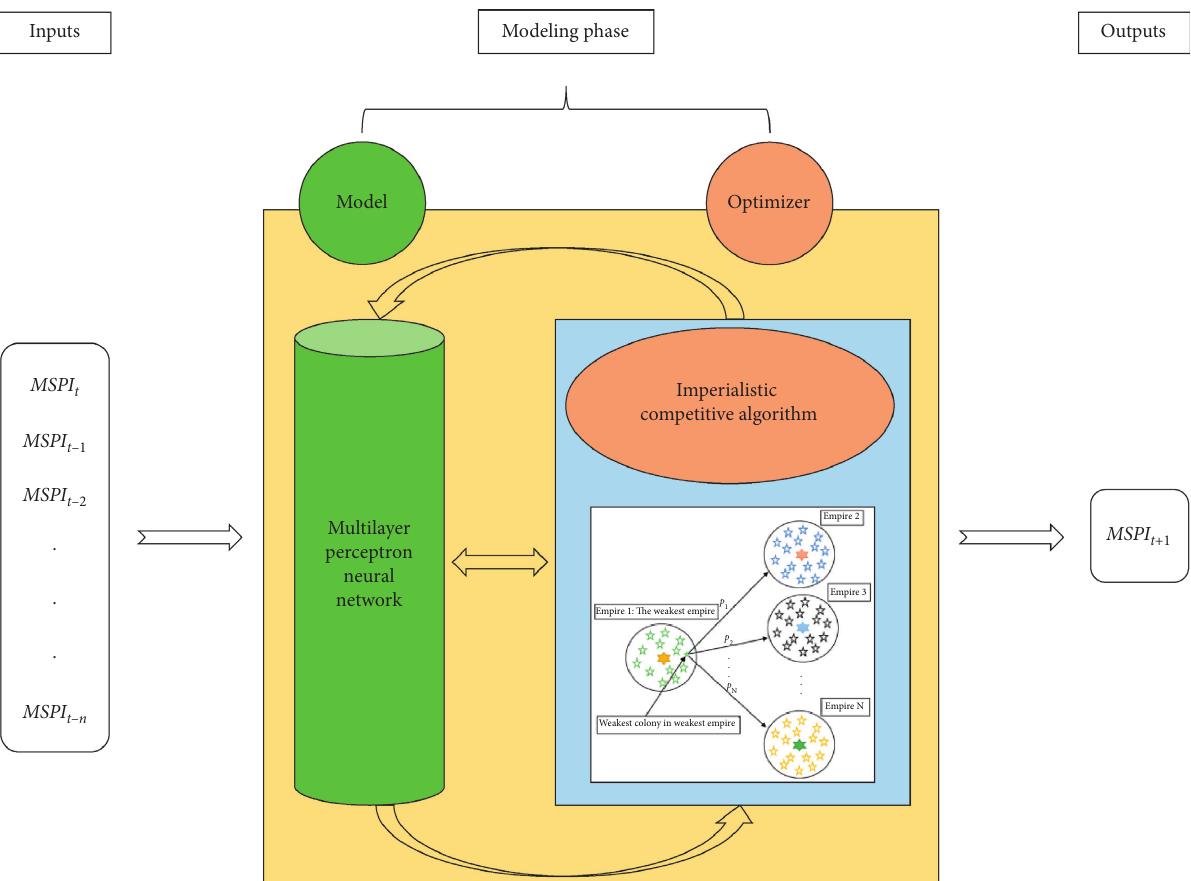
Figure 4: The interaction of the MLP model with Imperialist Competitive Algorithm in a schematic structure.